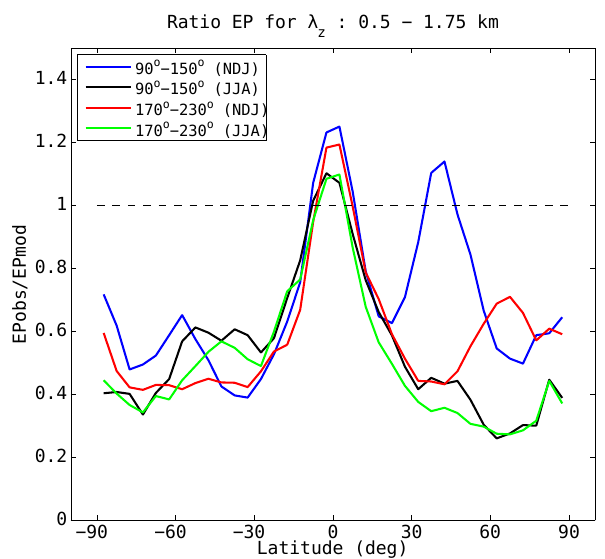
Figure 11. Ratio of the observed E S p to the model value by saturated GW theory during November–December–January (NDJ, solid line) and June–July–August (JJA, dashed line). Blue and black lines cor- respond to the ratio in region (a). Red and green lines correspond to the ratio in region